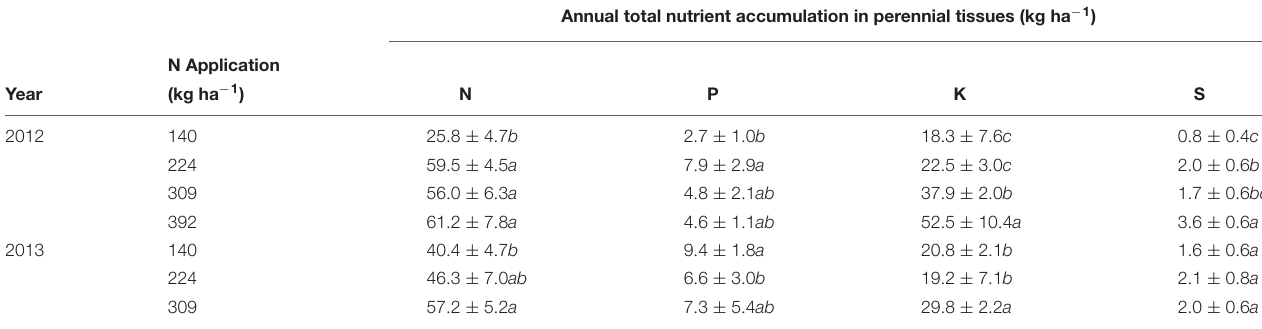
TABLE 7 | Annual nutrient increment in perennial biomass calculated as the difference in nutrient content of the tree at the beginning and the end of